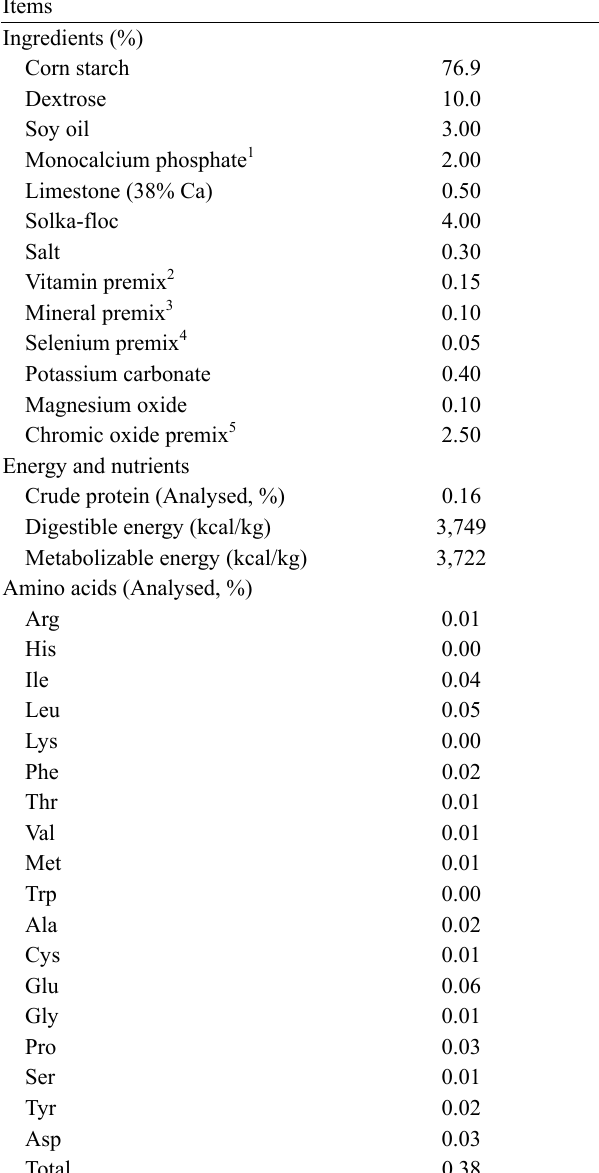
Table 3. Ingredient and chemical composition of nitrogen free diet to determine basal endogenous ileal amino acid loss in growing